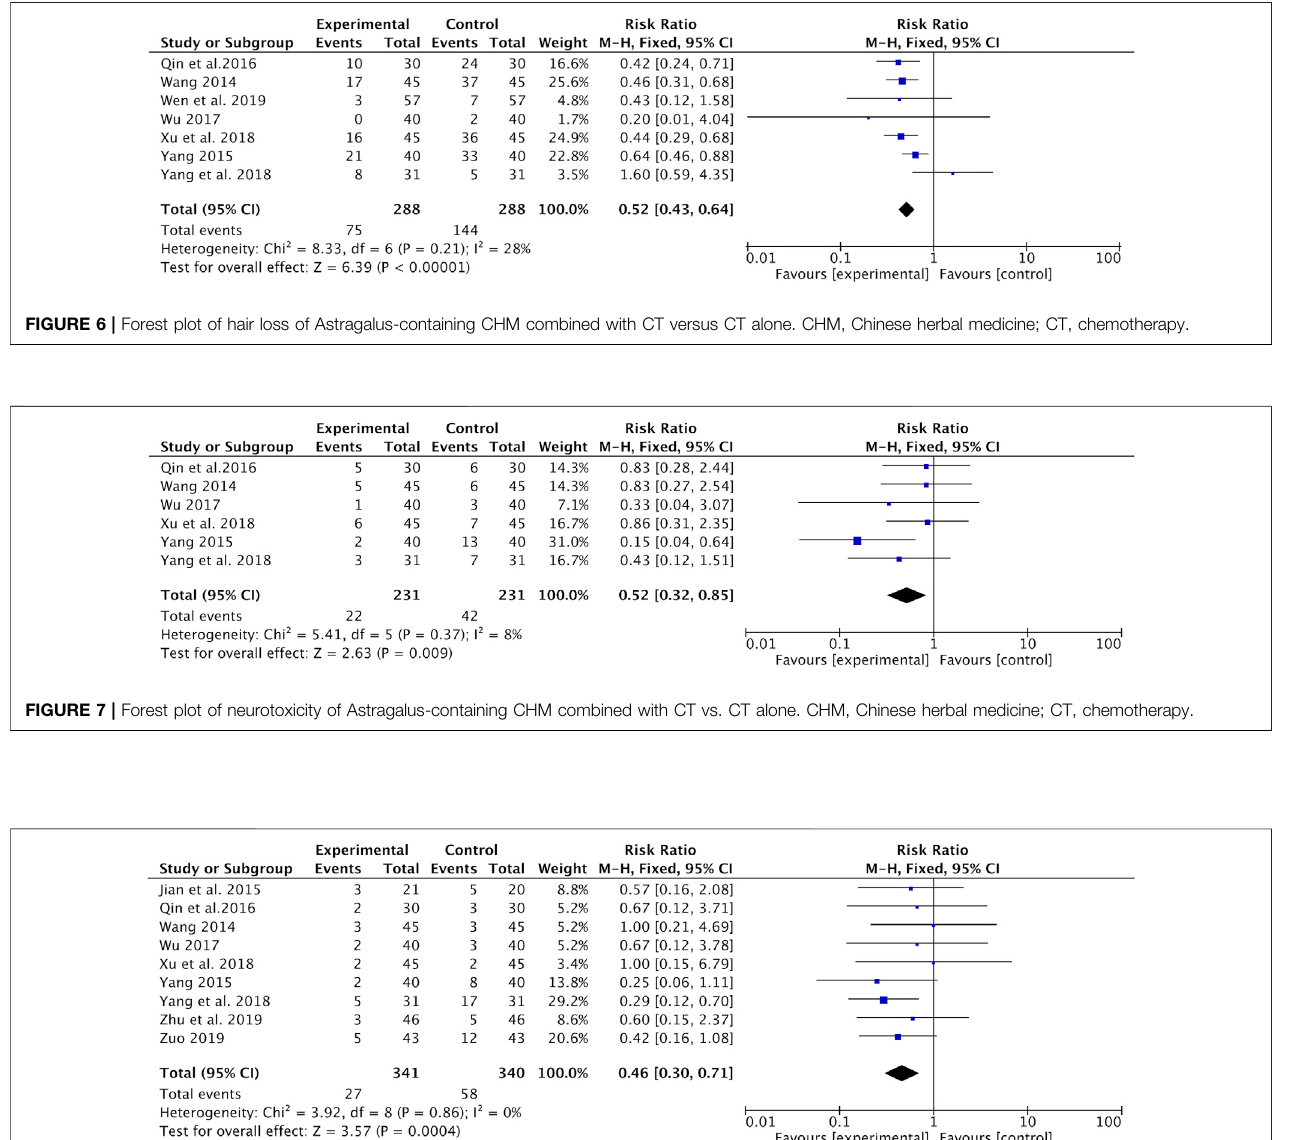
Frontiers in Pharmacology |